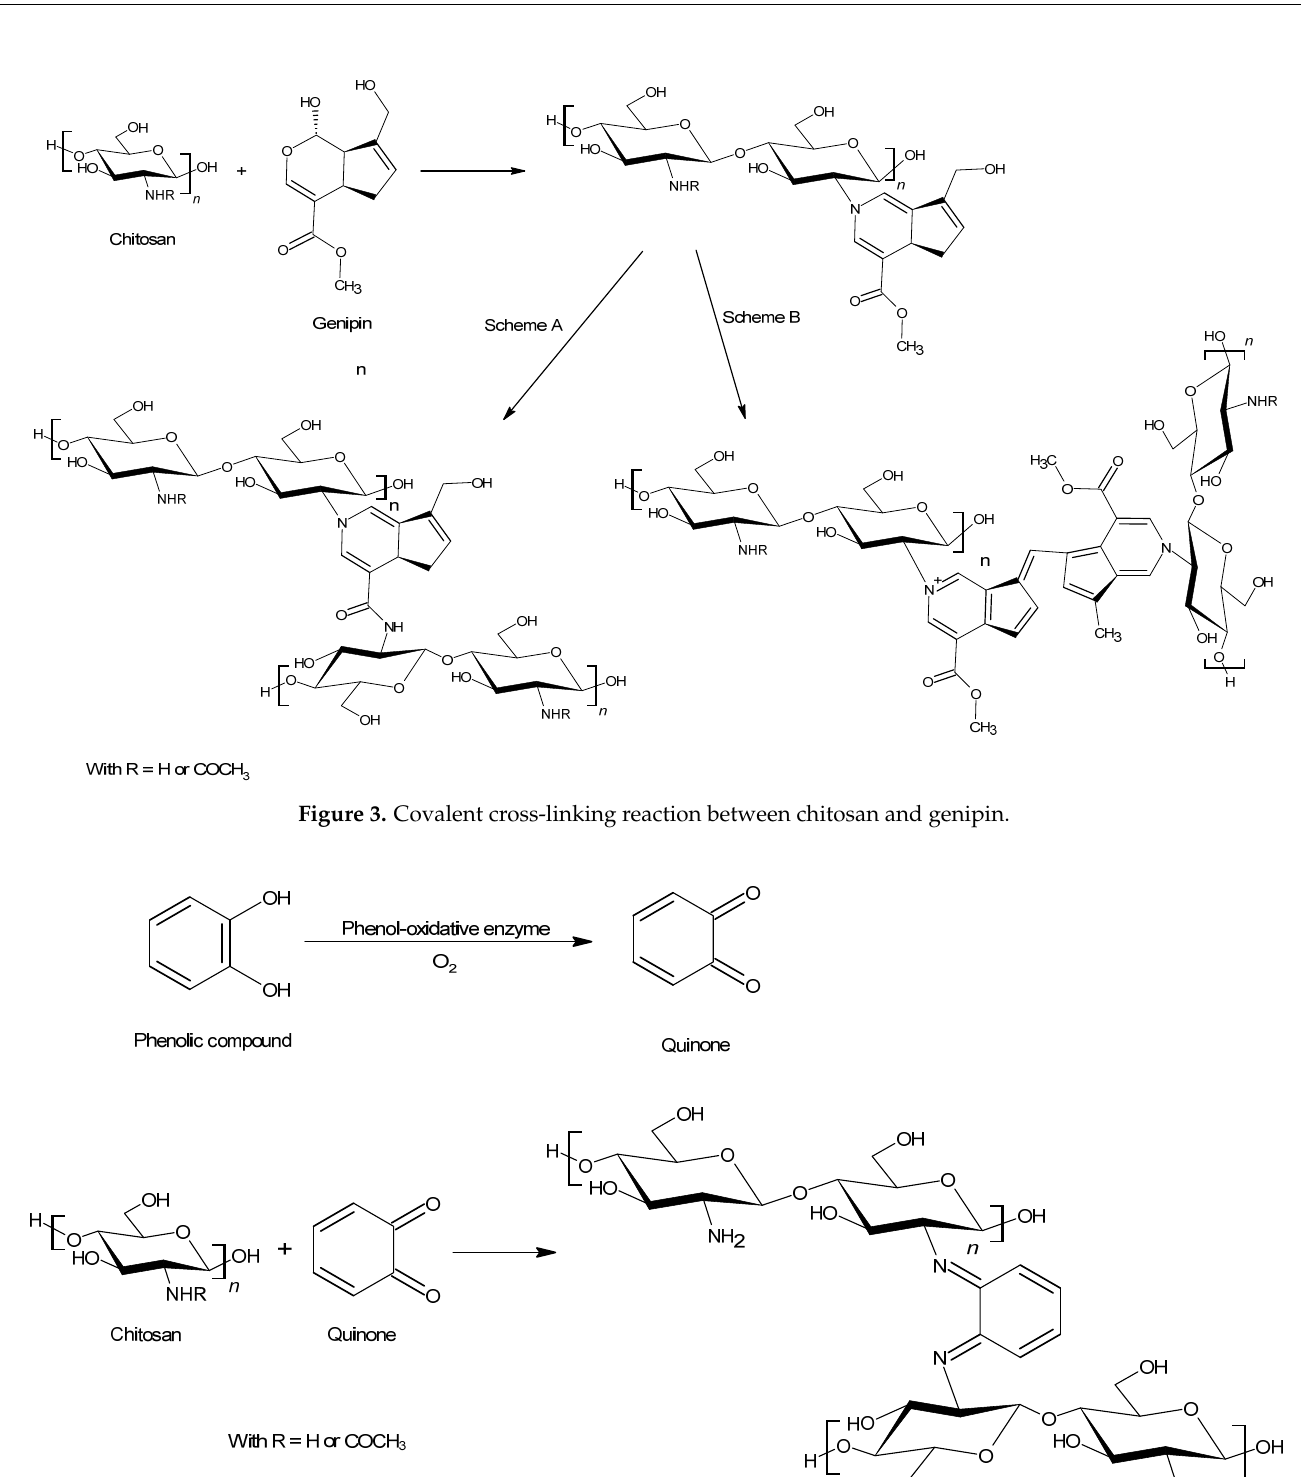
n n Figure 5. Ionic cross-linking reaction between chitosan and a negatively charged cross-linker . Chitosan, as a cationic polyelectrolyte, is able to react with negative reagents to form ionic interactions and to create a cross-linked system. Acids such as sulfuric acid is a good candidate for this process [85]. It would protonate chitosan to form the ammonium cations